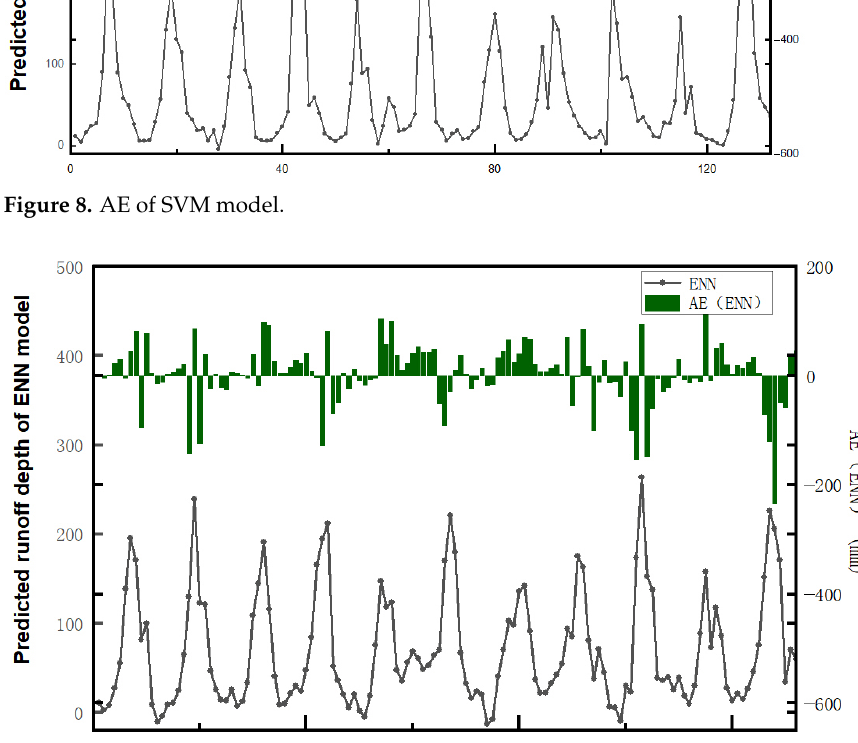
Figure 8. AE of SVM model.